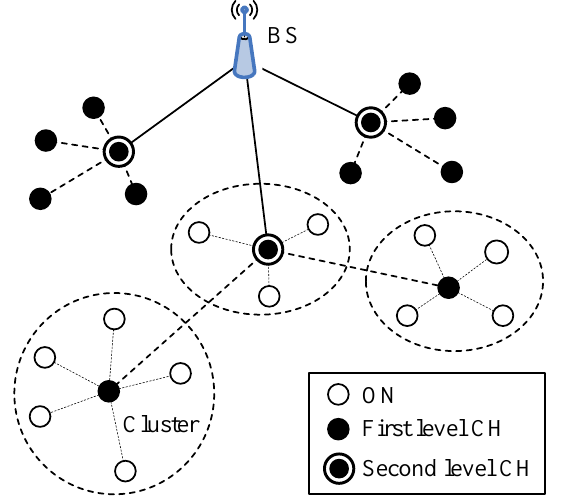
Figure 9. Illumination of the 2-tier Clustering Topology in